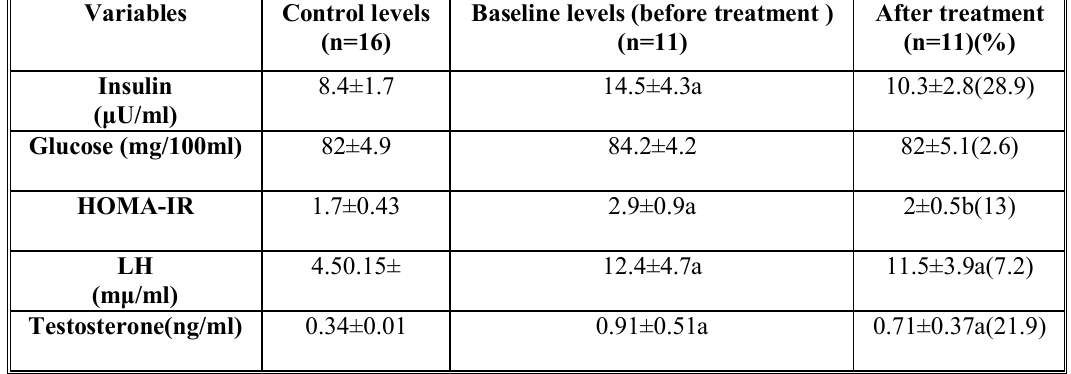
Table (3) : Effect of treatment with metformin(1500mg/day) on levels of insulin , glucose , HOMA-IR,LH and tstosterone in group ΙΙ.